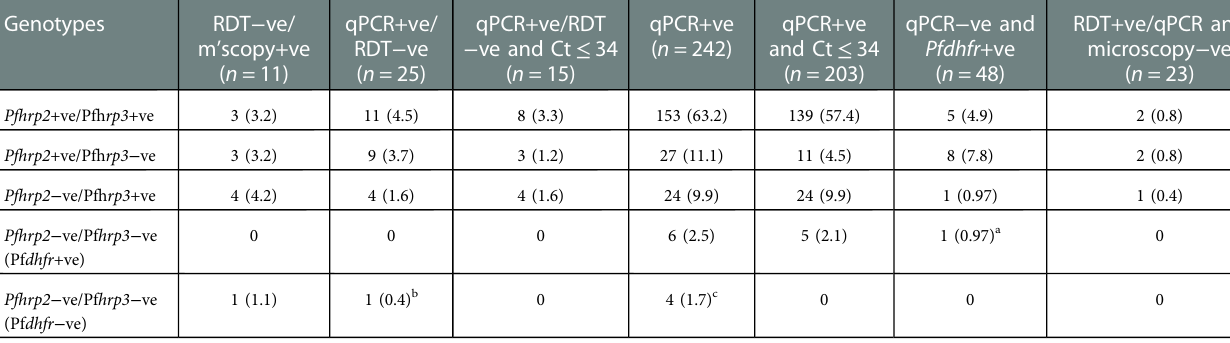
TABLE 1 A summary of the Pfhrp2 , Pfhrp3 and pfdhfr genotyping results from different sample categories.